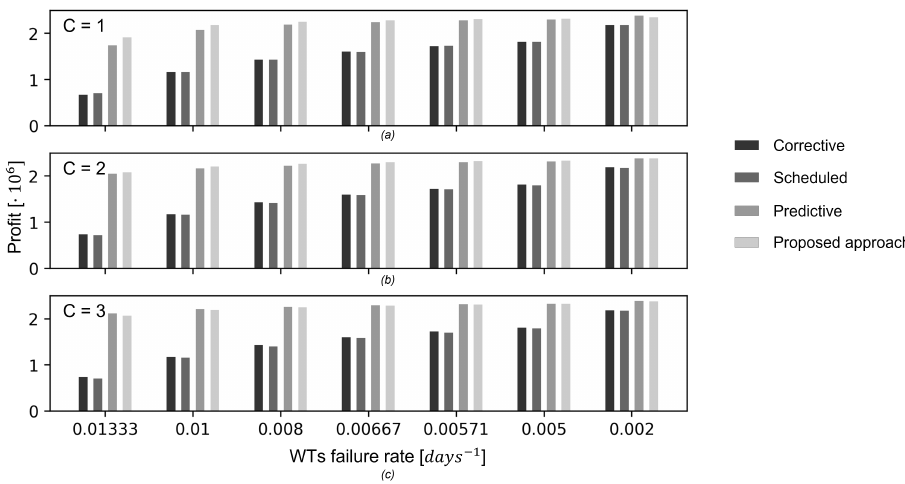
Figure 8. Performance of the considered policies in terms of average profit as a function of the WTs failure rate in the test episodes with C = 1 ( a ), C = 2 ( b ), and C = 3 ( c ), without re-training.